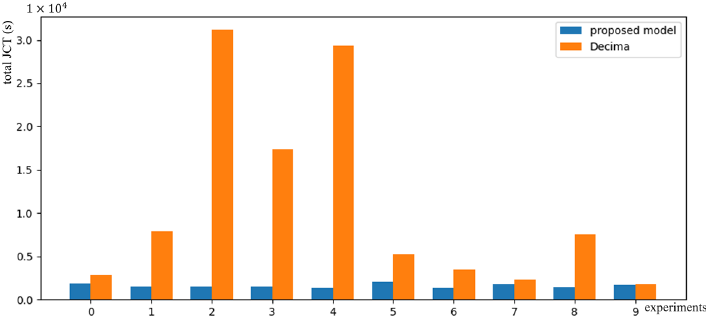
Figure 9. Result on the mixed dataset of 1000 DAGs.